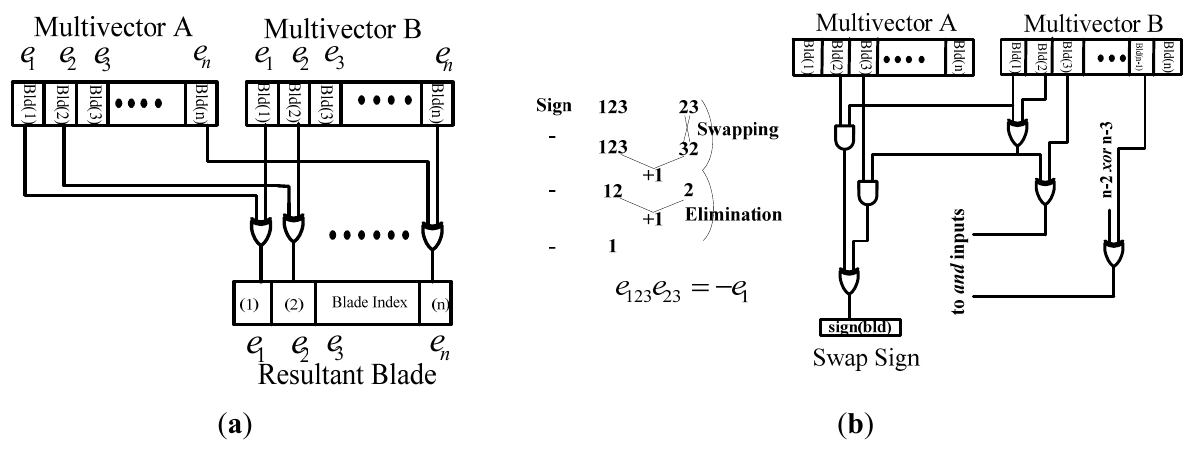
Figure 3. Computing and swapping of basis blades. ( a ) Basis vector computation; ( b ) Swap computation.